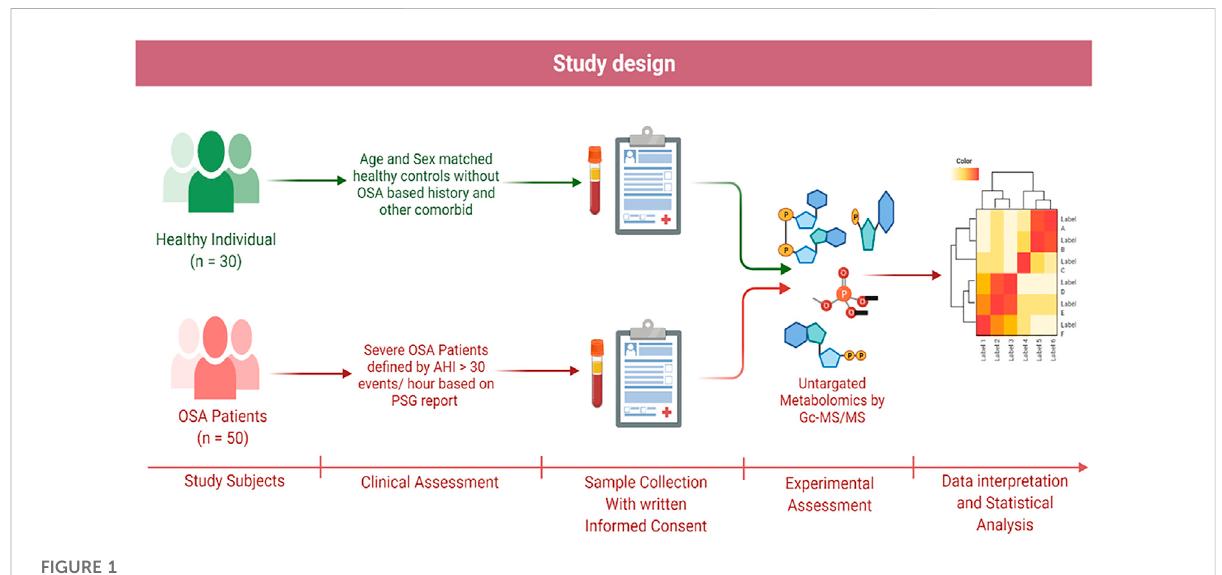
FIGURE 1 Schematic representation of study